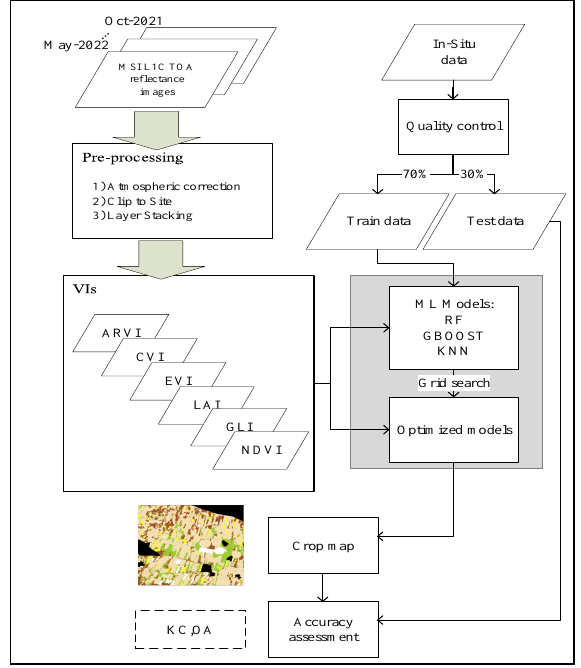
Figure 2. Flowchart of proposed method.